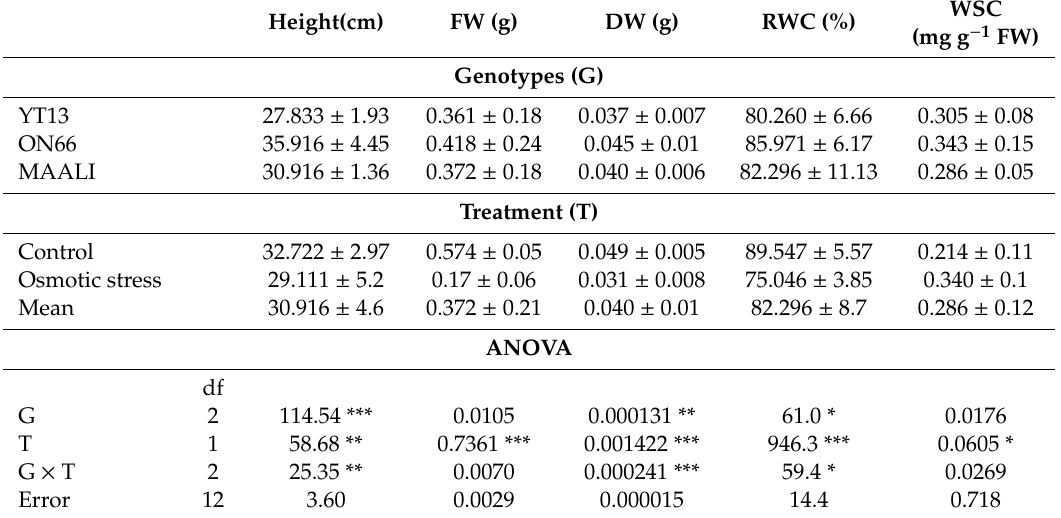
Table 1. Genotype and treatment e ff ects on Plant Height (Height), Fresh weight (FW), Dry weight (DW), relative water content (RWC), and Water-soluble Carbohydrates (WSC) of durum wheat genotypes grown under osmotic stress. In the lower panel, the ANOVA analysis is given. Legend: G, genotype; T, Treatment, *, **, *** significant at p < 0.05, p < 0.01 and p < 0.001